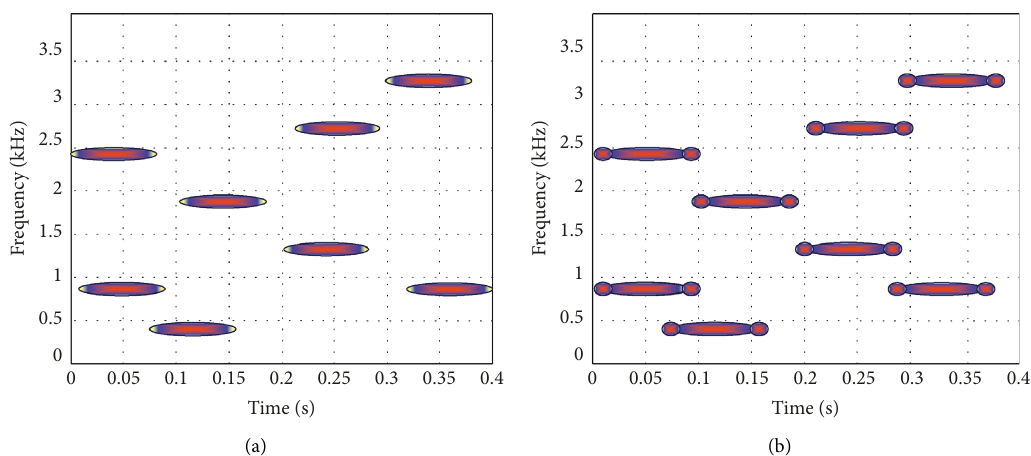
Figure 4: STFTs with different window lengths. (a) H � N /4+1. (b) H � N /10 +1.